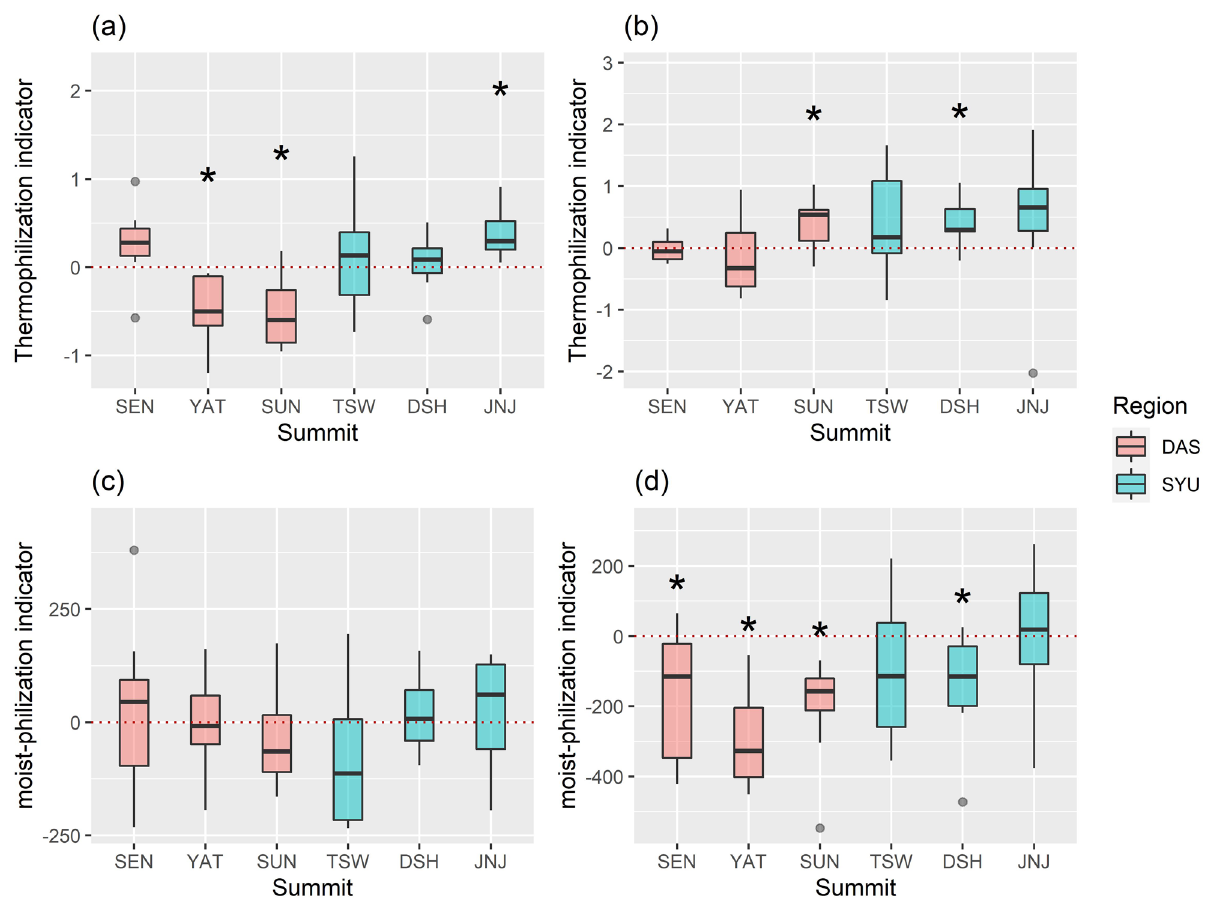
Figure 5. The themophilization and moist-philization indicators of each summit (the Dashueiku Mountain (DAS) region: SEN, YAT and SEN; the Syue Mountain (SYU) region: TSW, DSH and JNJ) during the monitoring periods. ( a ) and ( c ) show the indicators from the first survey to the second; ( b ) and ( d ) show the indicators from the second survey to the third; the star above each summit boxplot means that the indicator value is significantly different from zero in the